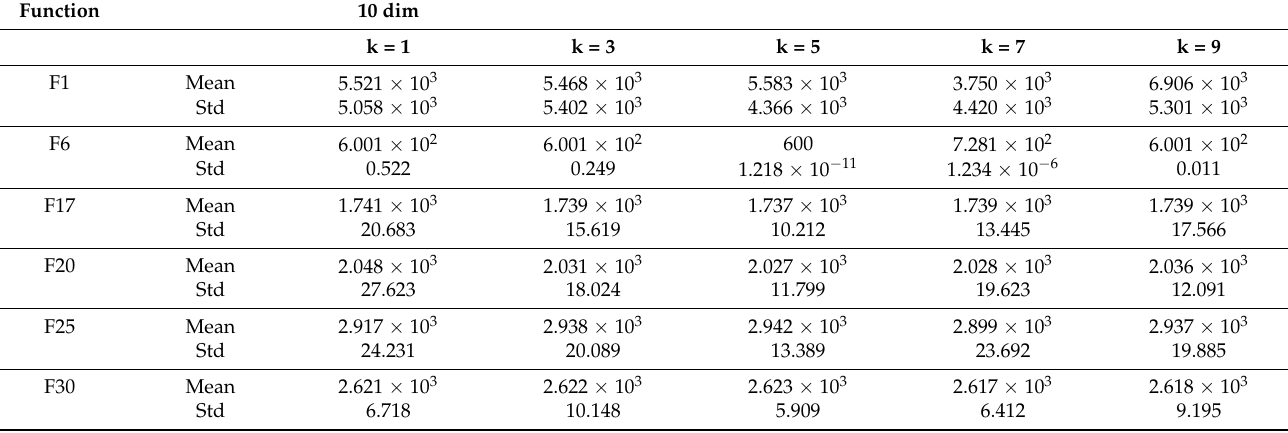
Table 1. The 10-dimensional function test.